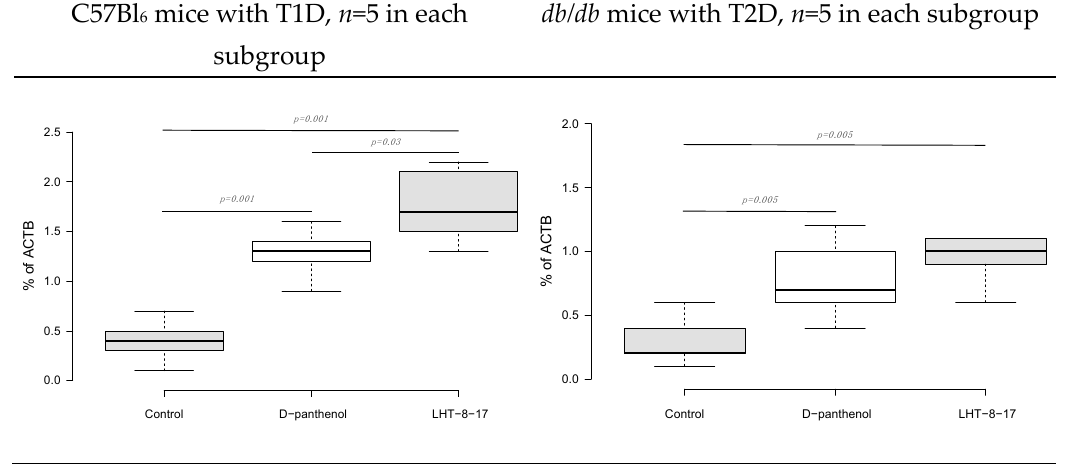
Figure 8. FGFR3 gene transcript expression as a percentage of the ACTB housekeeping gene mRNA concentration in fresh granulations on the day of experimental treatment with LHT-8-17. Data are presented as the median ± SD; significance of differences was estimated using ANOVA and the Tukey criterion.